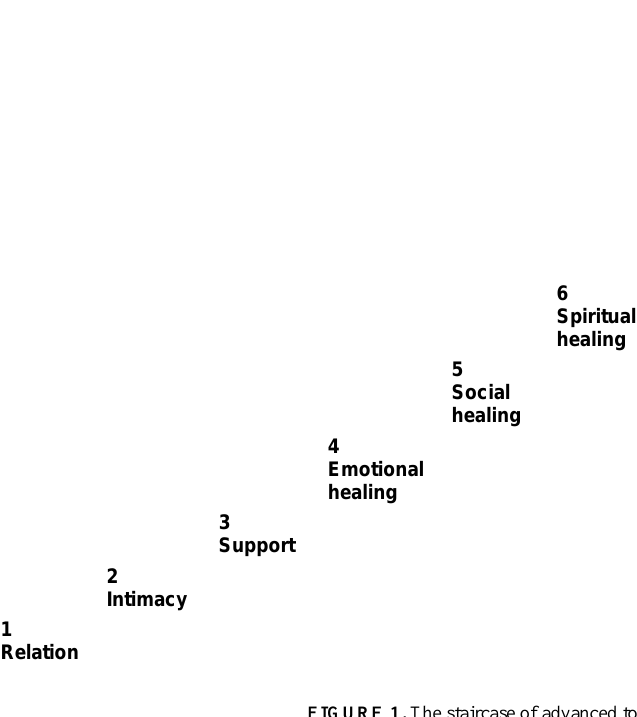
FIGURE 1. The staircase of advanced tools for holistic